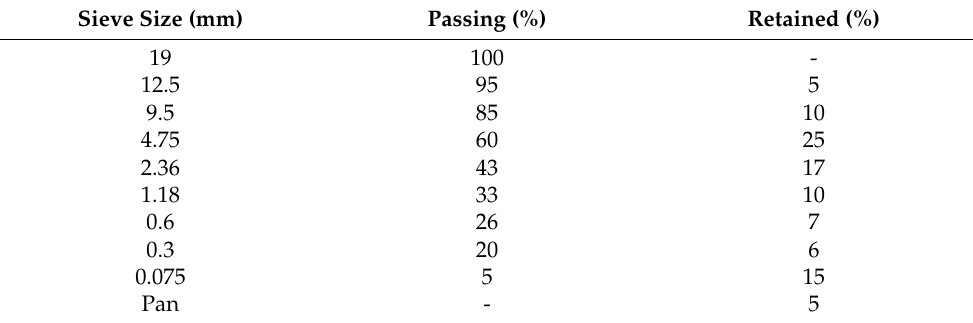
Table 3. Gradation of the EAF steel slag and granite